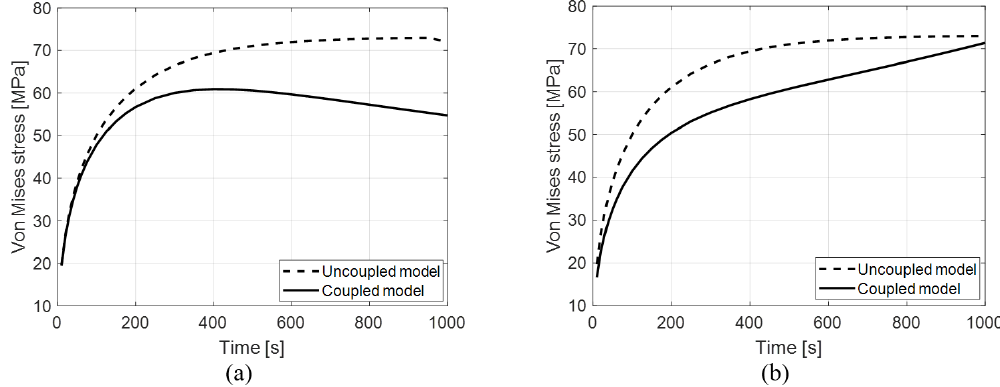
Figure 8. Von Mises stress as a function of insertion ( a ) and extraction ( b ) time. The results are derived with physical parameters of Table